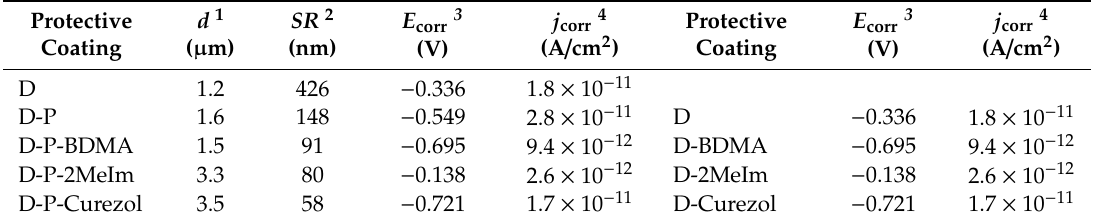
Table 3. Morphological and electrochemical characterization of the protective